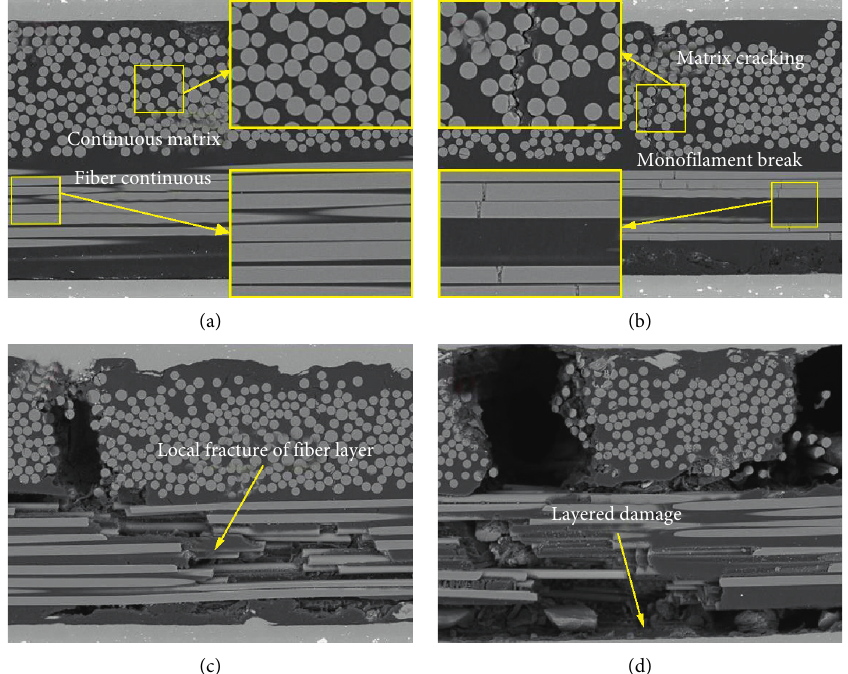
Figure 14: Microstructure of each stage of cross-ply laminates bending test observed by SEM (FEI Quanta 200) [51]. (a) Elastic phase. (b) Plastic phase. (c) Fiber failure segment. (d) Layer failure segment.